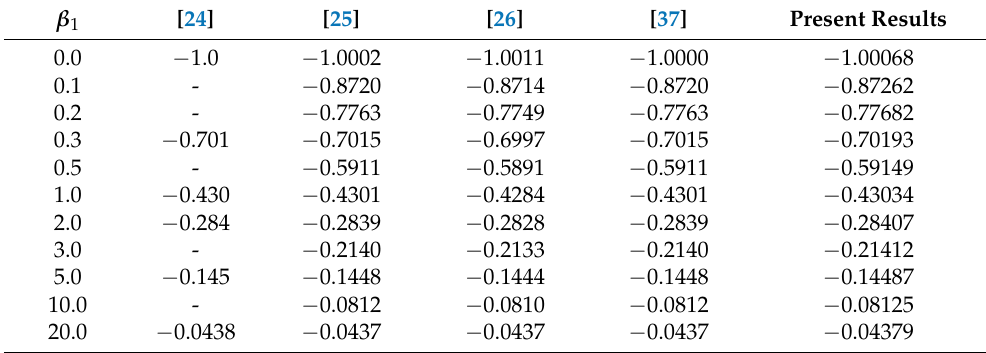
1 2 s for various values of β 1 , when M = 0 and A = 1000.